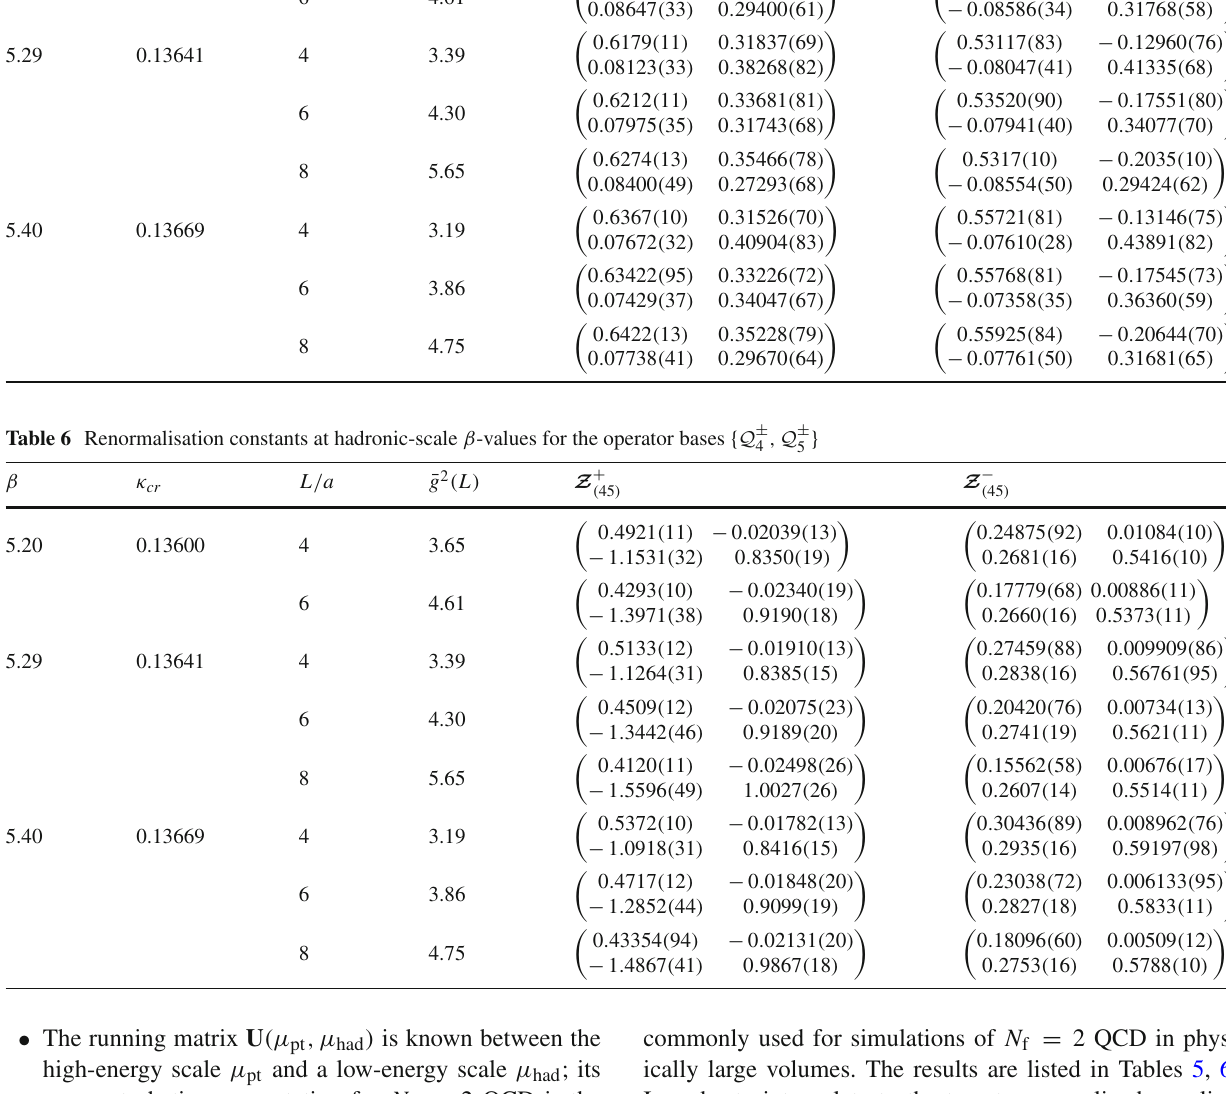
Table 5 Renormalisation constants at hadronic-scale β -values for the operator bases { Q ± β